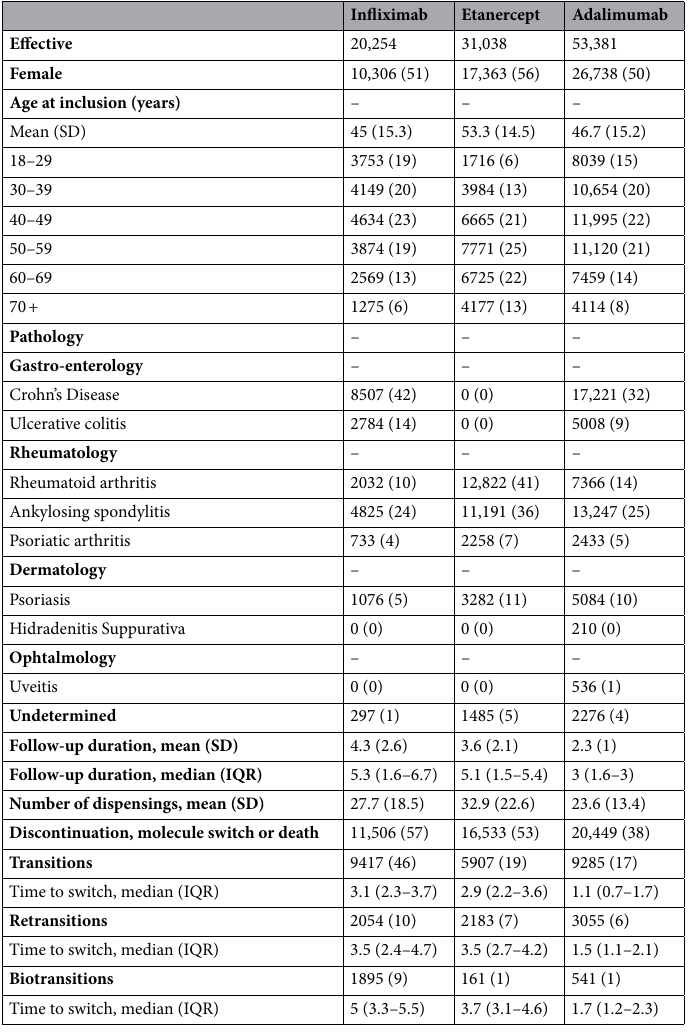
Table 2. Prevalent users characteristics at inclusion and during the study follow-up, by molecule. Figures are no. (%) unless stated otherwise. IQR, interquartile range; SD, standard